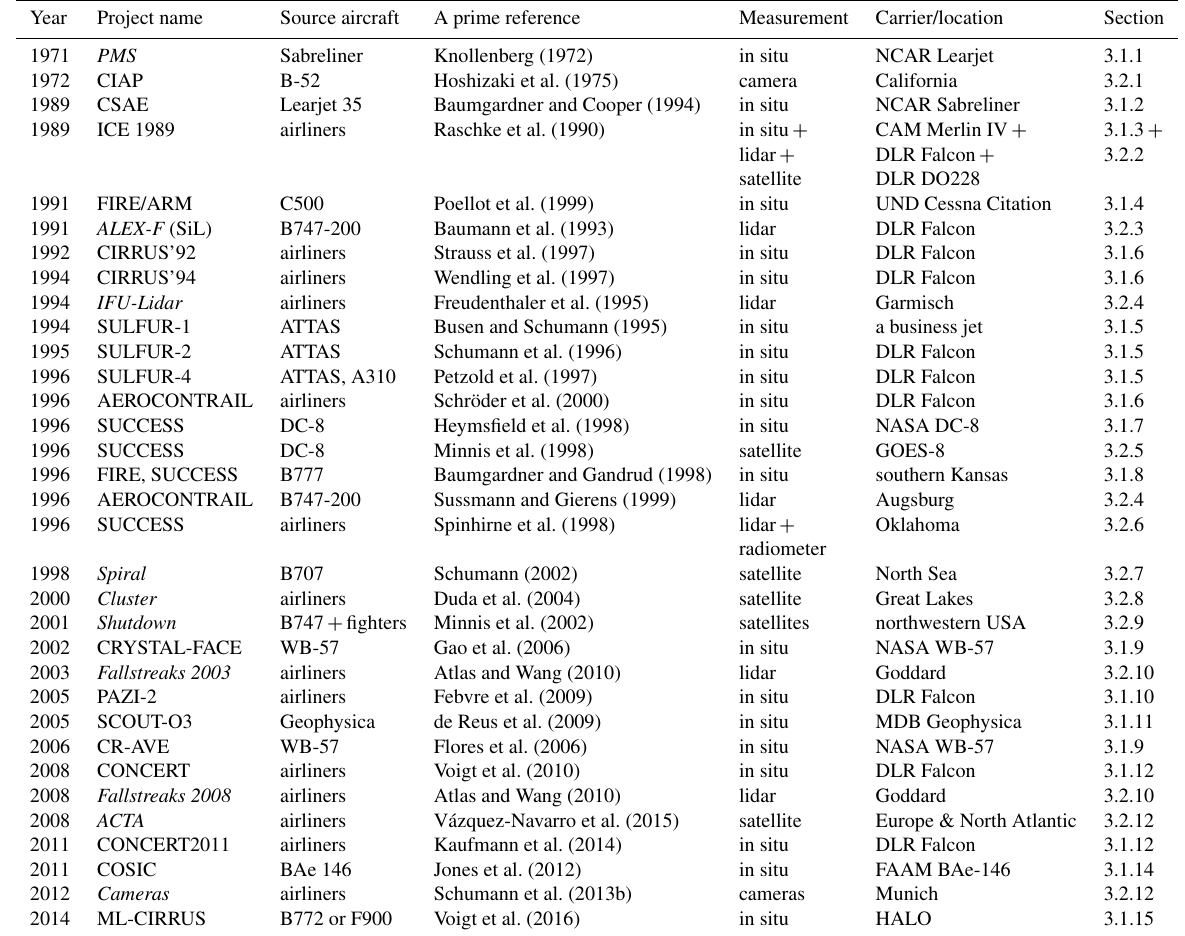
Table 7. Observations included in the contrail library (ad hoc project names in